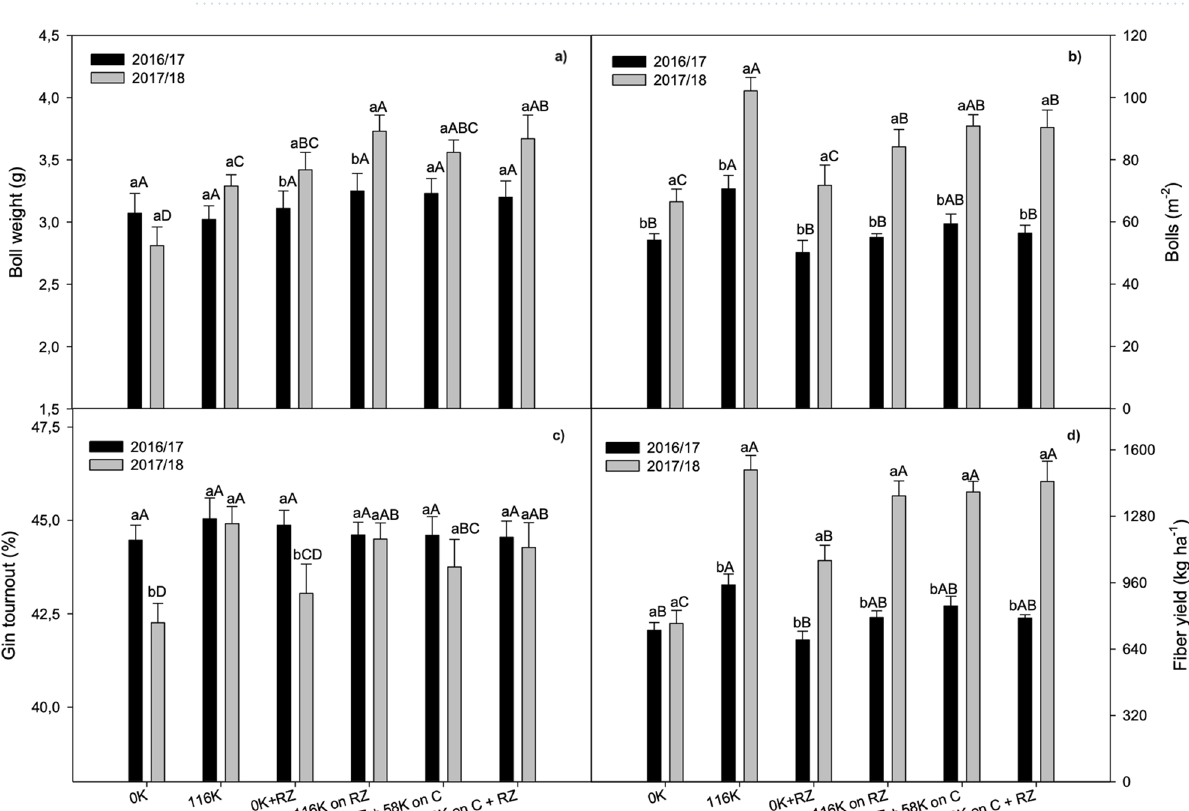
Figure 3. Cotton yield and yield components as affected by potassium fertilization management and season. A > B for K management within each growing season and a > b for growing season within K